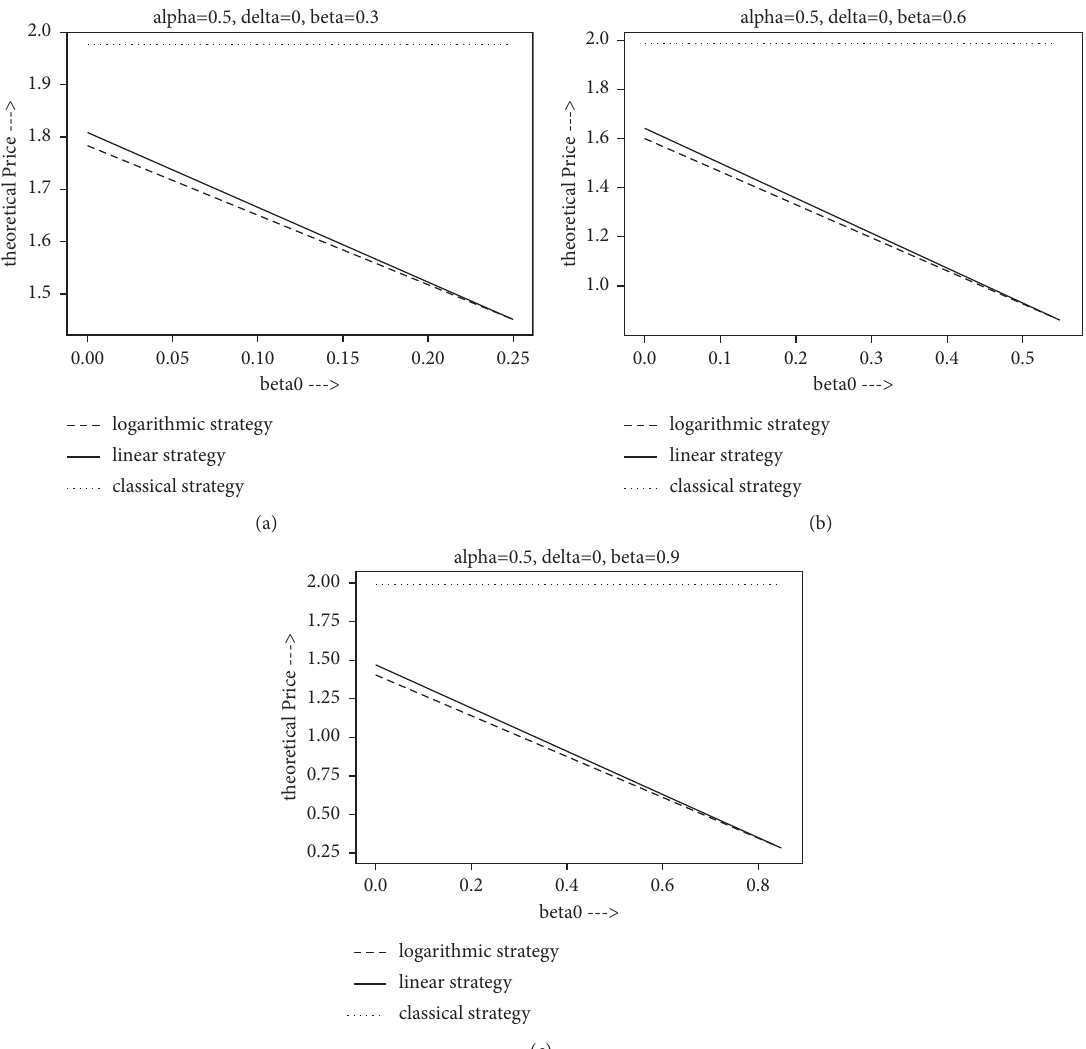
Figure 4: The theoretical price as a function of δ when α � 0 . 5, β � 1, and β alpha=0.5, delta=0, beta=0.3